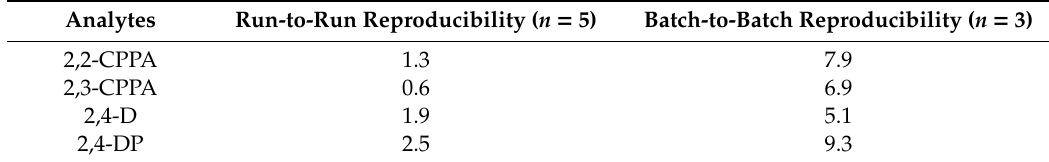
Table 3. RSDs for the peak areas on di ff erent poly (OMA-co-TRIM) monoliths.